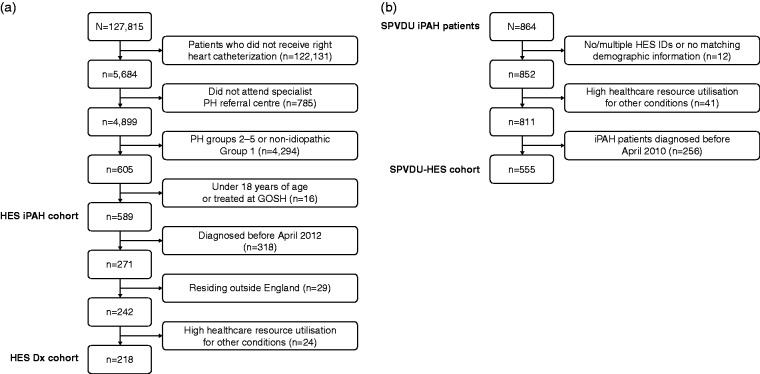
Patient flow in the pilot study. Dx, diagnosis; GOSH, Great Ormond Street Hospital; HES, Hospital Episodes Statistics; PH, pulmonary hypertension; iPAH, idiopathic pulmonary arterial hypertension; SPVDU, Sheffield Pulmonary Vascular Disease Unit.